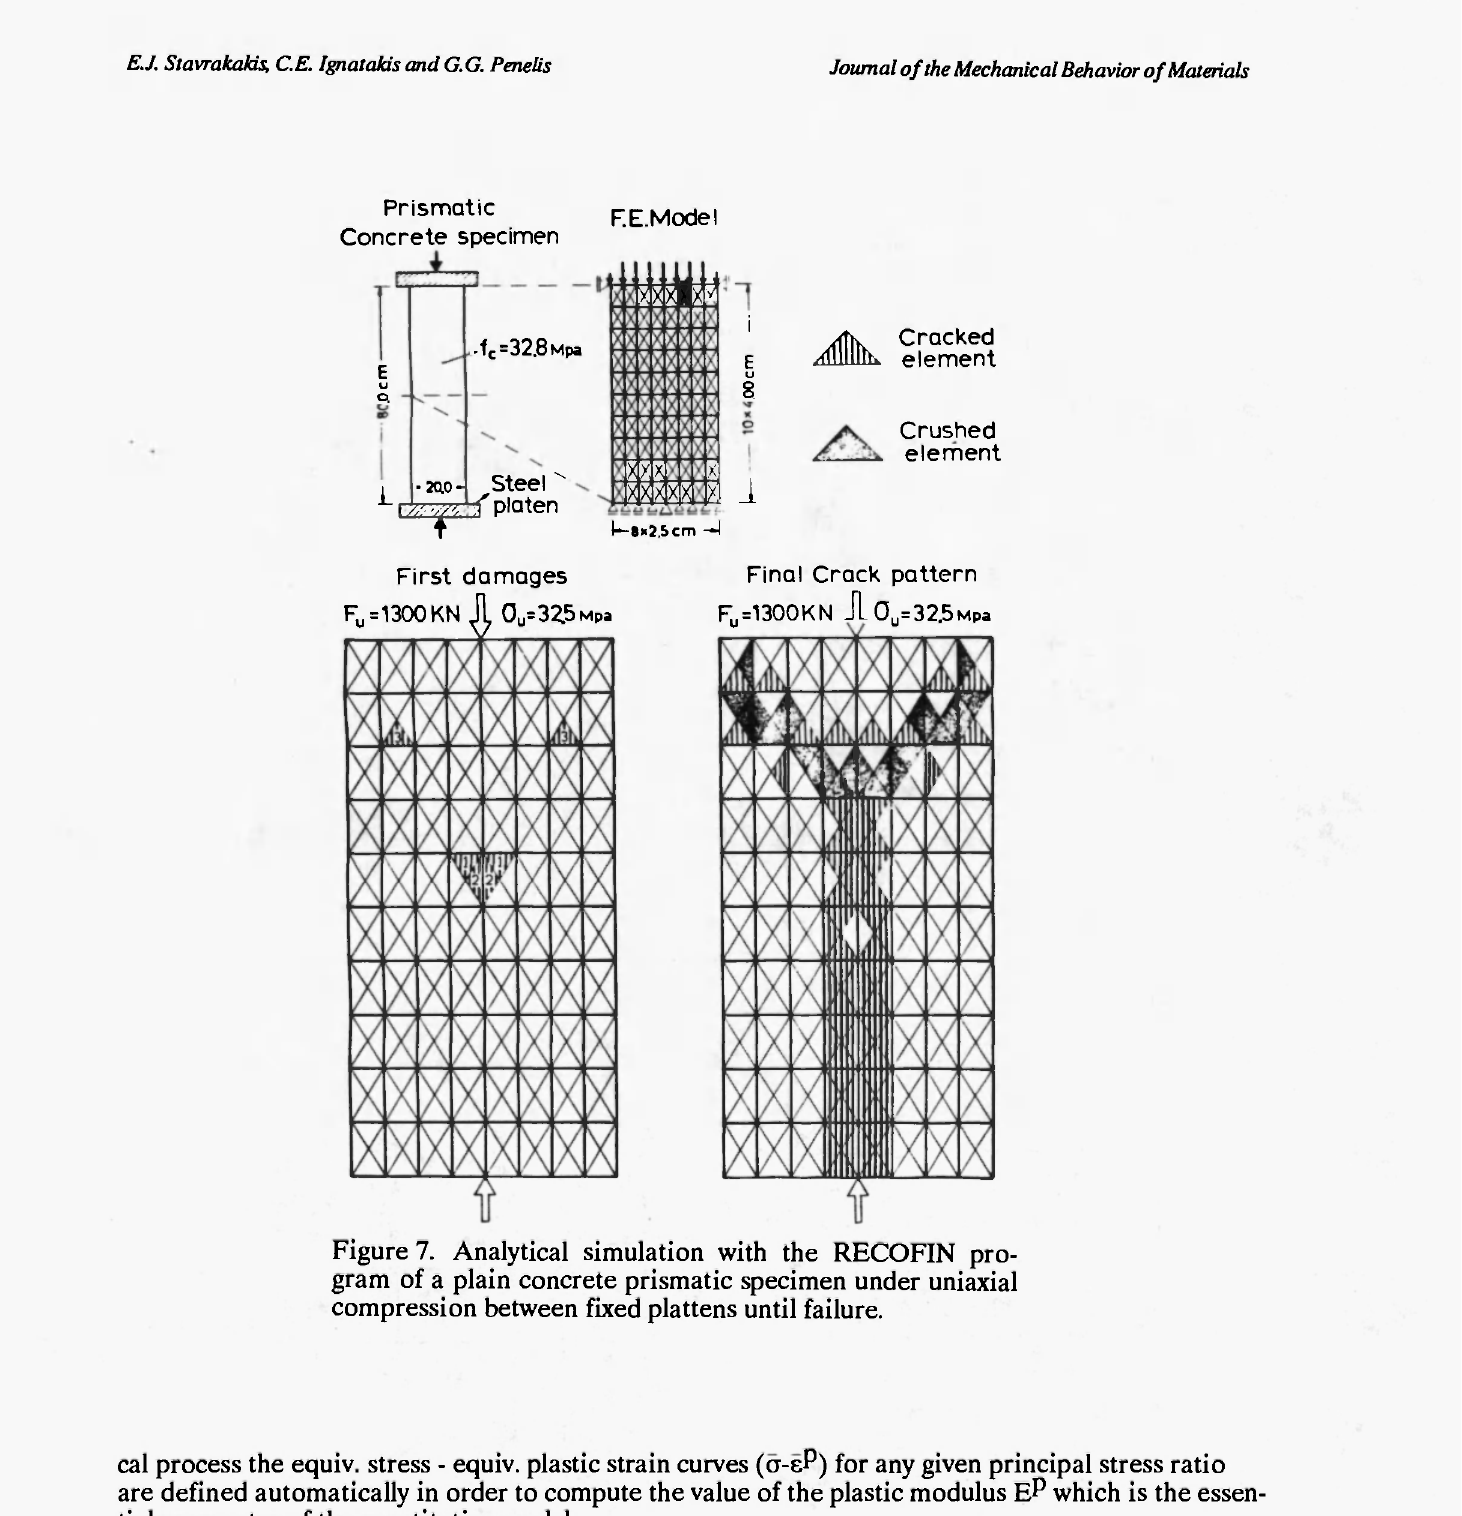
Figure 7. Analytical simulation with the RECOFIN pro- gram of a plain concrete prismatic specimen under uniaxial compression between fixed plattens until